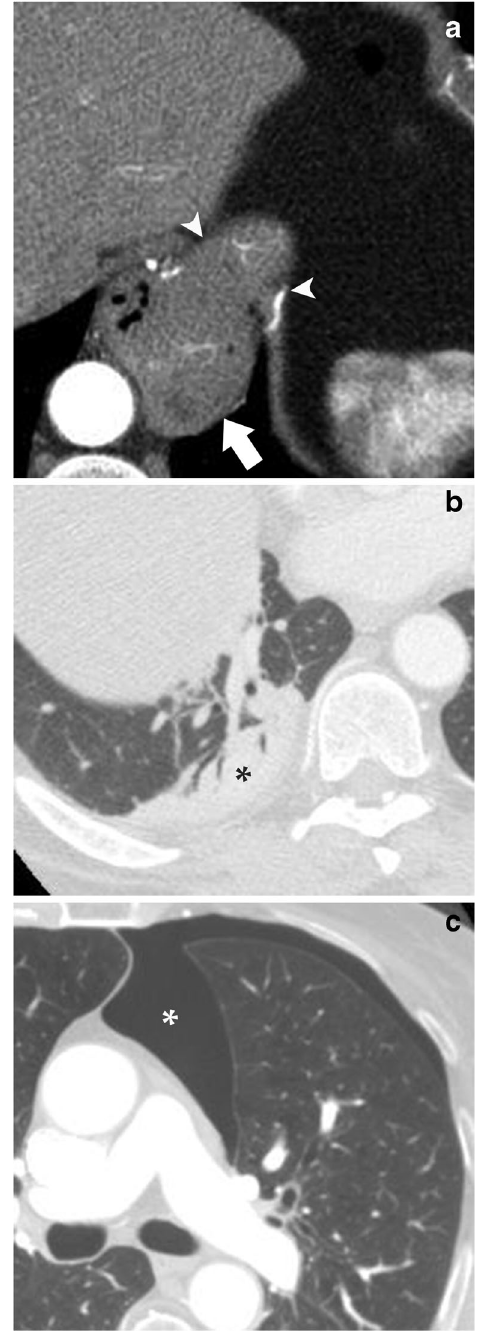
Fig. 2 CT pure axial images showing examples of extracardiac diseases. a Axial image at the supra-diaphragmatic level showing a large hiatal hernia ( arrow ) extending into the thoracic cavity through the esophageal hiatus of the diaphragm ( arrowheads ). b Axial image with lung window, at the heart level, showing pulmonary consolidation ( asterisk ) with air bronchogram in the posterior-basal segment of the right lung. c Axial image with lung window, at the pulmonary artery bifurcation level, show- ing a significant anterior mainly para-mediastinal pneumothorax ( asterisk ) of the left